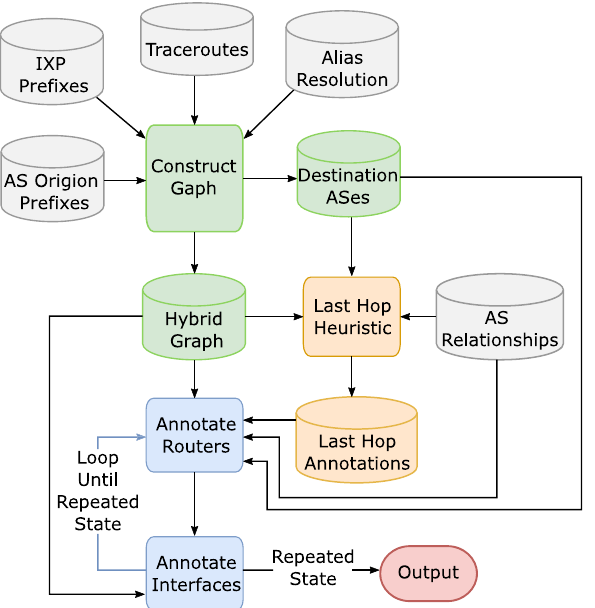
Figure 1. The flow chart of bdrmapIT 11